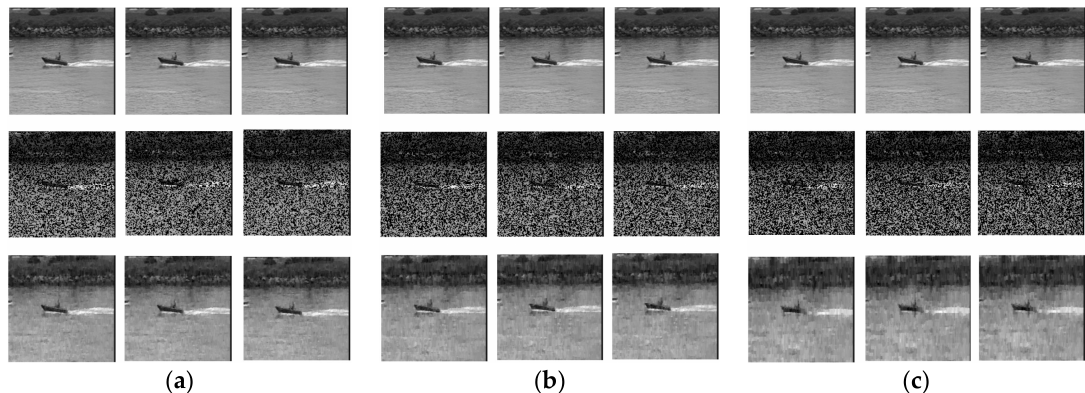
Figure 9. Comparison of the first three frames of “coastguard “at different BER: ( a ) BER = 0.0062; ( b ) BER = 0.0081; and ( c ) BER = 0.0107. The first line of pictures are the original video frames, the second line of pictures are the result of direct transmission of video frames, and the third line of pictures is the result of transmission of video frames after distributed compressive video sensing coding.